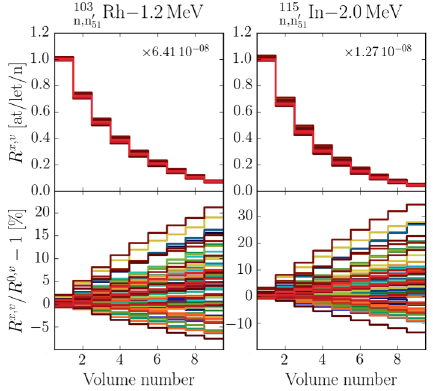
Figure 7. Inelastic reaction rate distributions (top) for the rhodium (left) and indium (right) elements and the relative vari- ation between the random cross sections (bottom)